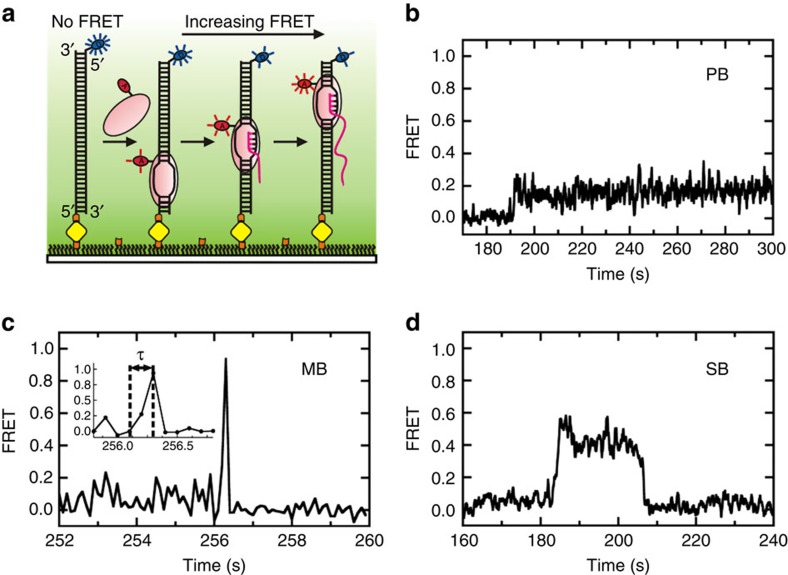
Single molecule FRET visualization of RNAP transcription.(a) Single-molecule FRET setup: surface-immobilized Cy3-labelled dsDNA (FRET donor in blue) with an RNAP promoter near the surface is used for transcription by Cy5-RNAP (FRET acceptor in red). In the presence of NTPs, three classes of events are observed for Cy5-RNAP: (b) promoter binders (PB), which are characterized as long static binding events at low FRET (∼0.2), (c) moving bubbles (MB) with a rapid increase to high FRET (≥0.5) followed by a sharp decrease to 0 FRET (inset shows the average peak rise time τ) and (d) stalled bubbles (SB) that rapidly increase to 0.2–0.5 FRET and remain there, before a sharp drop back to 0 FRET. The total number of events observed ranges from 78 to 87, as reported in Supplementary Table 2. The time resolution of FRET trajectories shown here is 100 ms, and these experiments were also conducted at 15–30 ms time resolution (Supplementary Figs 4–9).